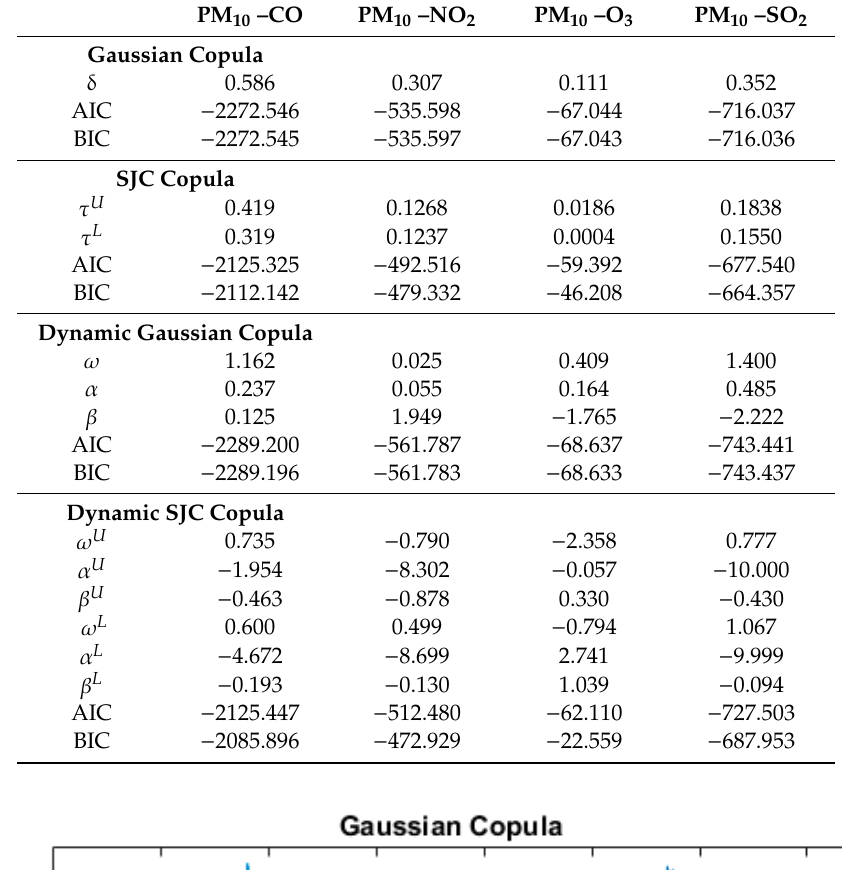
Table 4. Parameter estimates for constant and time-varying copulas.